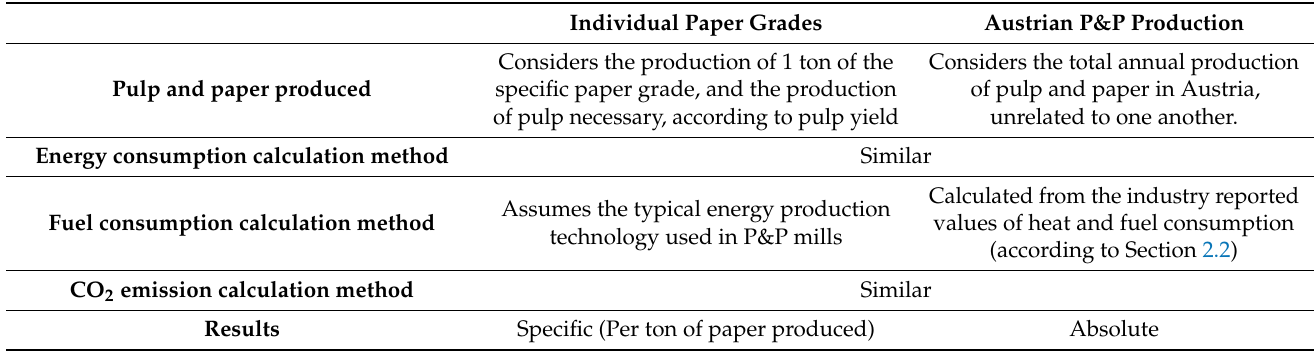
Table 5. Comparison of the two variants of the model used.